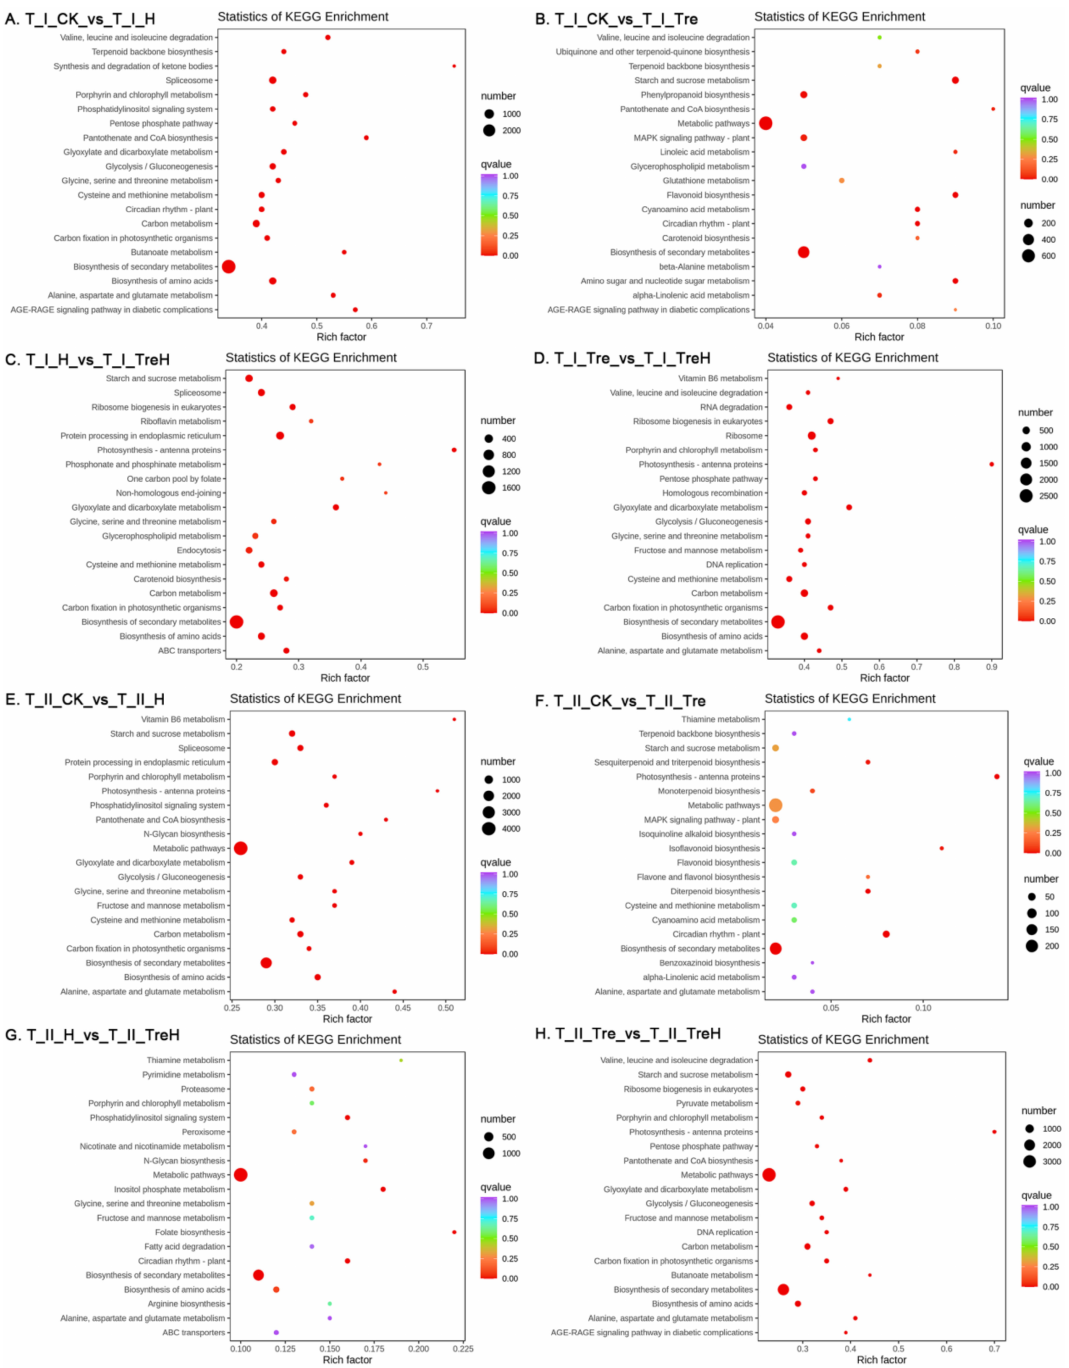
Figure 7. KEGG enrichment of the DEGs. T—the transcriptome; I—Yangmai 18; II—Yannong 19; CK—control group; H—heat stress treatment for 24 h; Tre—trehalose pretreatment for 3 d; TreH—trehalose pretreatment for 3 d followed by high-temperature treatment for 24 h. The ordinate represents the KEGG pathway. The abscissa represents the rich factor. The larger the rich factor, the greater the enrichment degree. The larger the dot, the more the number of differential genes enriched by the pathway. The redder the color of the dot, the more significant the